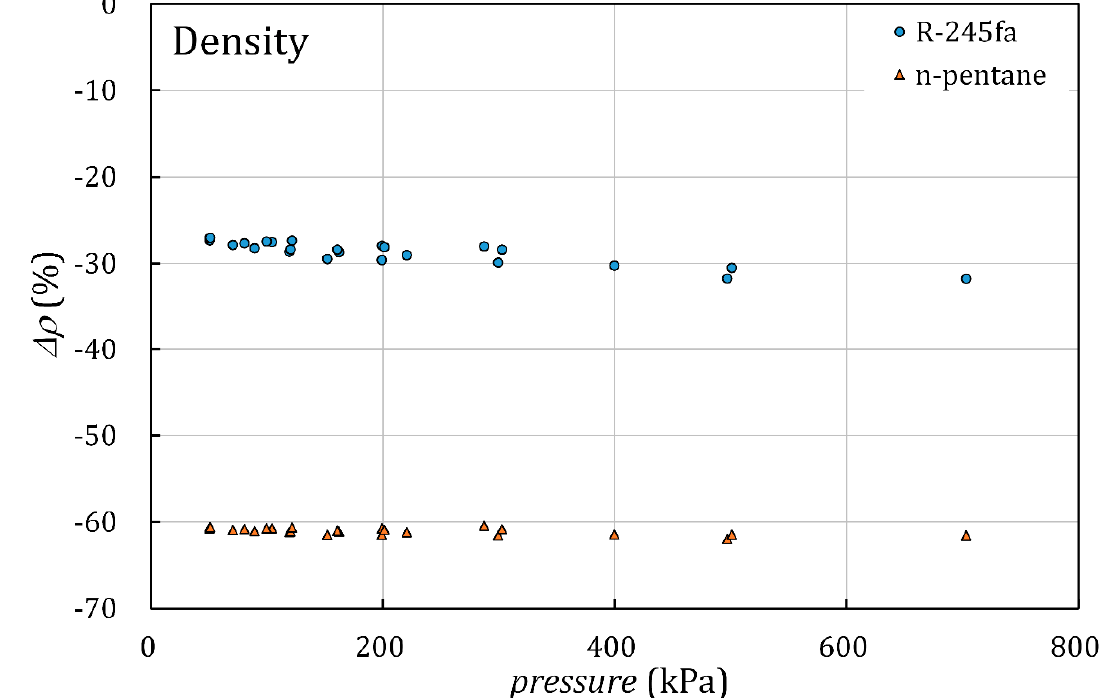
Figure 10. Comparison of the density of HFE-356mmz with that of R-245fa and n-pentane. The base line corresponds to the density of HFE-356mmz.